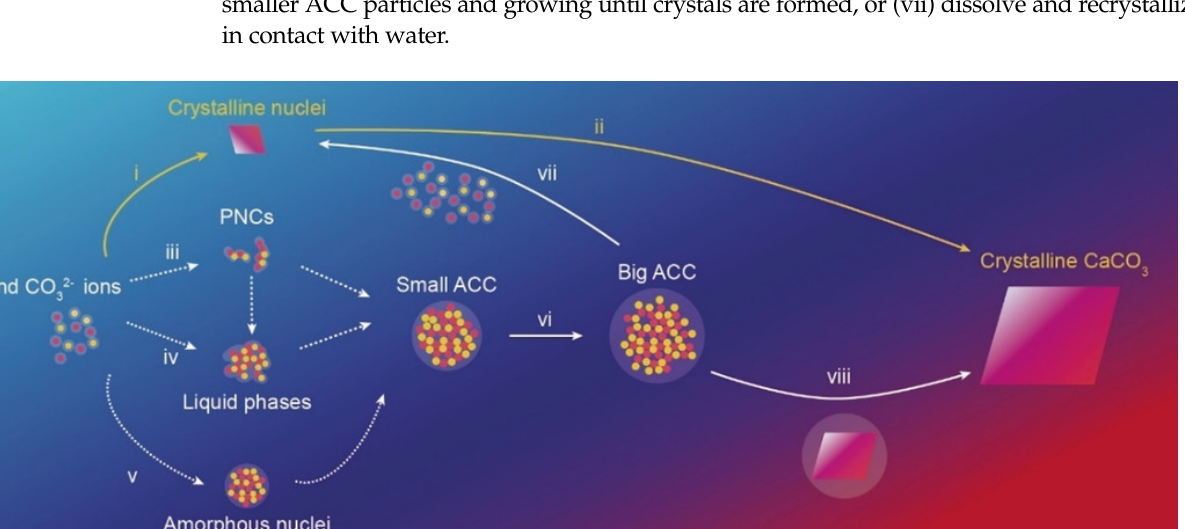
Figure 2. The crystal structure and macroscopic morphology (obtained from a scanning electron microscope (SEM)) of three crystalline phases of CaCO 3 particles: calcite ( top ), vaterite ( middle ), and aragonite ( bottom ).